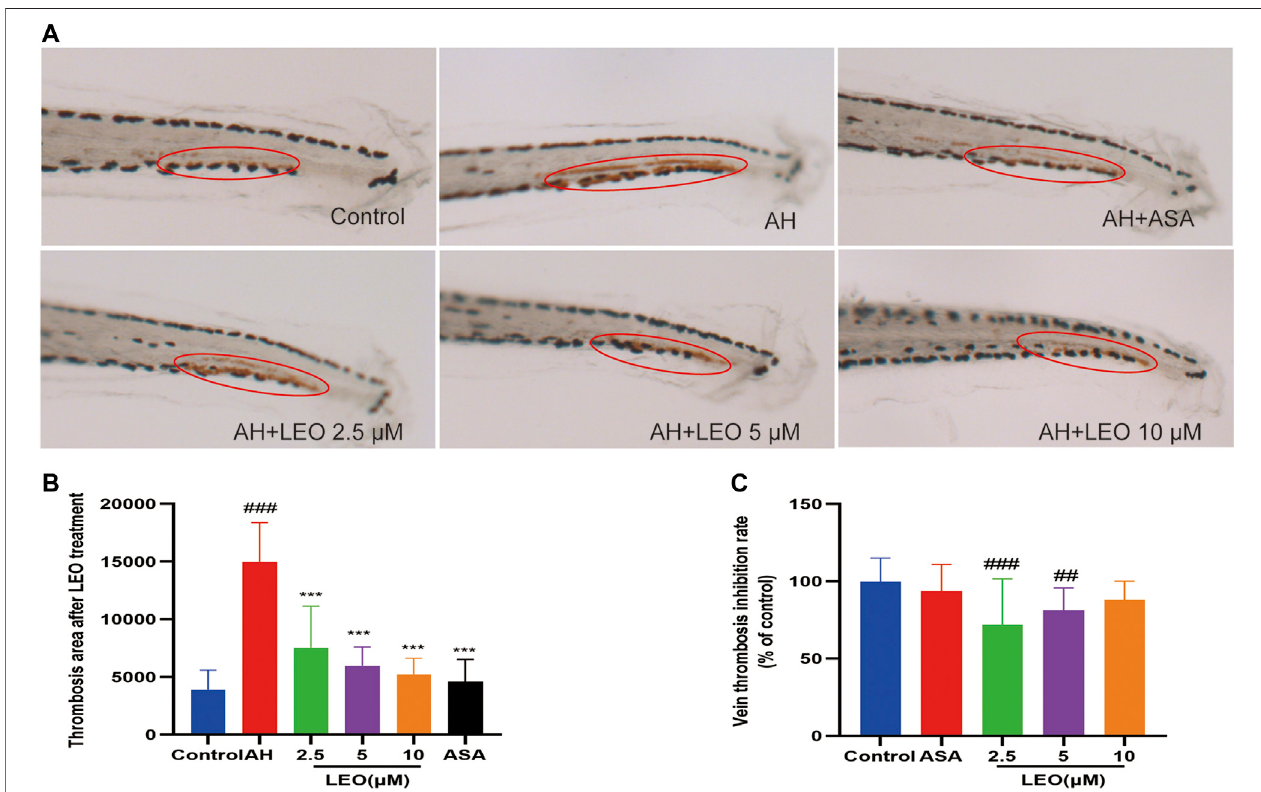
FIGURE4| EffectofLEOonAH-inducedthrombosisinzebra fi shlarvae. (A) Imagesofvenousthrombosisinthetailofzebra fi sh,redcircleindicatesthethrombusin thecaudalvein. (B) TheeffectofLEOonthrombusareaofzebra fi sh. (C) Theveinthrombosisinhibitionrate(%ofcontrol).Dataarerepresentedasmean ± SD( n (cid:1) 20).# p < 0.05, ## p < 0.01 , ### p < 0.001 vs Control group; * p < 0.05 , ** p < 0.01, *** p < 0.001 vs AH